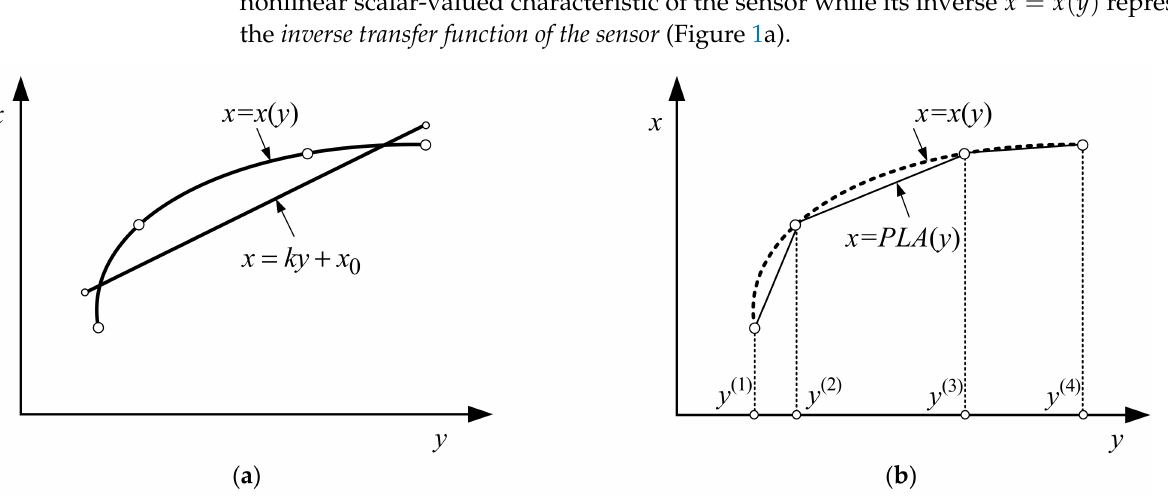
Figure 1. Graphical representation of inverse sensor transfer functions: ( a ) inverse sensor transfer function x = x ( y ) and its linear approximation x = ky + x 0 ; ( b ) inverse sensor transfer function x = x ( y ) and its piecewise linear approximation x = PLA ( y )